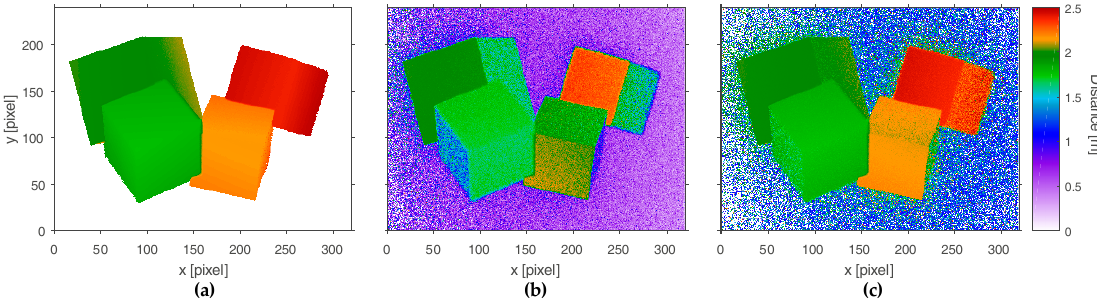
Figure 4. Reconstructed ToF distance images calculated from the average optical pathlength at each sensor pixel ( a ) without and ( b ) with a scattering medium (r =10 µm, ρ = 40 particles/cm 3 ) between sensor and scene. The distance underestimation amounts to about 25 cm for the center position of the right tilted surface of cube 2, 33 cm for the center position of the top surface of cube 3 and 56 cm for the center position of the right surface of cube 4. ( c ) Same as ( b ) in the hypothesis that all rays sampling a distance sensor-scene shorter than 61 cm are not contributing to the signal. The distance underestimation monitored at the same positions mentioned in ( b ) are reduced to about 6 cm, 10 cm and 16 cm,